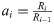
Dynamic response for a network with vessel radii that follow Murray’s law.A: Real and imaginary parts of the response of the network (in m
4) as a function of the level n at which obstructions occur. B: Real and imaginary parts of the ratio of two sequential resistances ai=RiRi−1 as a function of the level i of the underlying network. Note that we use the subindex i, whenever we refer to a property of the underlying network, we use the subindex n whenever we refer to the response of the whole network when obstructions occur at level n.